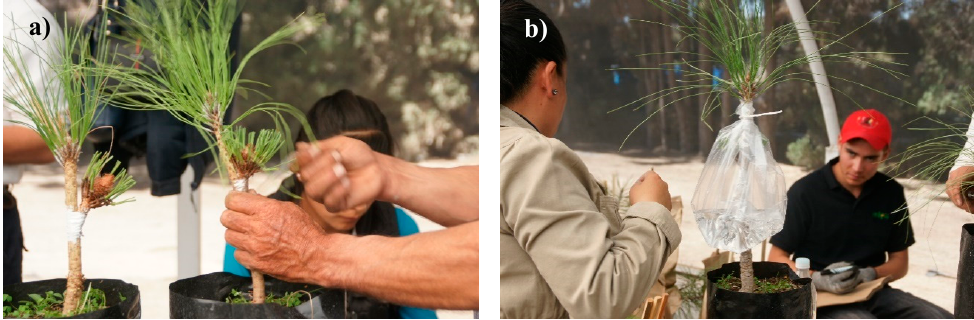
Figure 2. Final process of side veneer grafting. ( a ) Tying the graft. ( b ) Generating the microclimate.